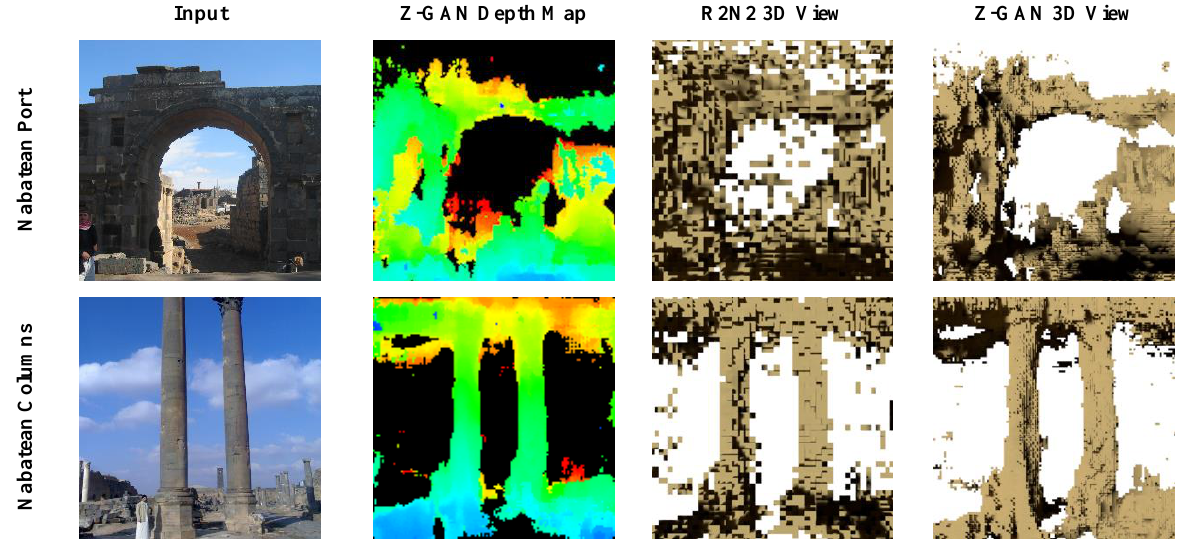
Figure 5: Results of 3D reconstruction using Z-GAN on the crowdsourcing dataset (Borsa, Syria - courtesy of Rekrei project) with respect to a state-of-the-art method R2N2.